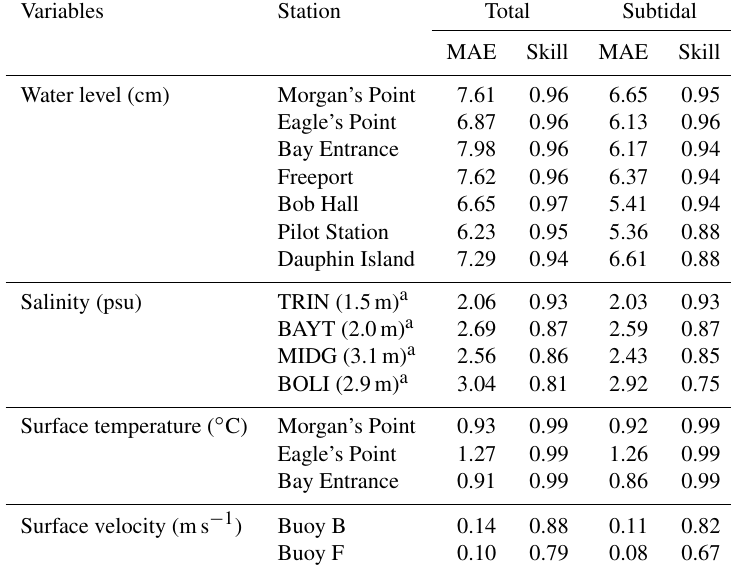
Table 1. Error estimates for model–data comparison for 2007–2008.